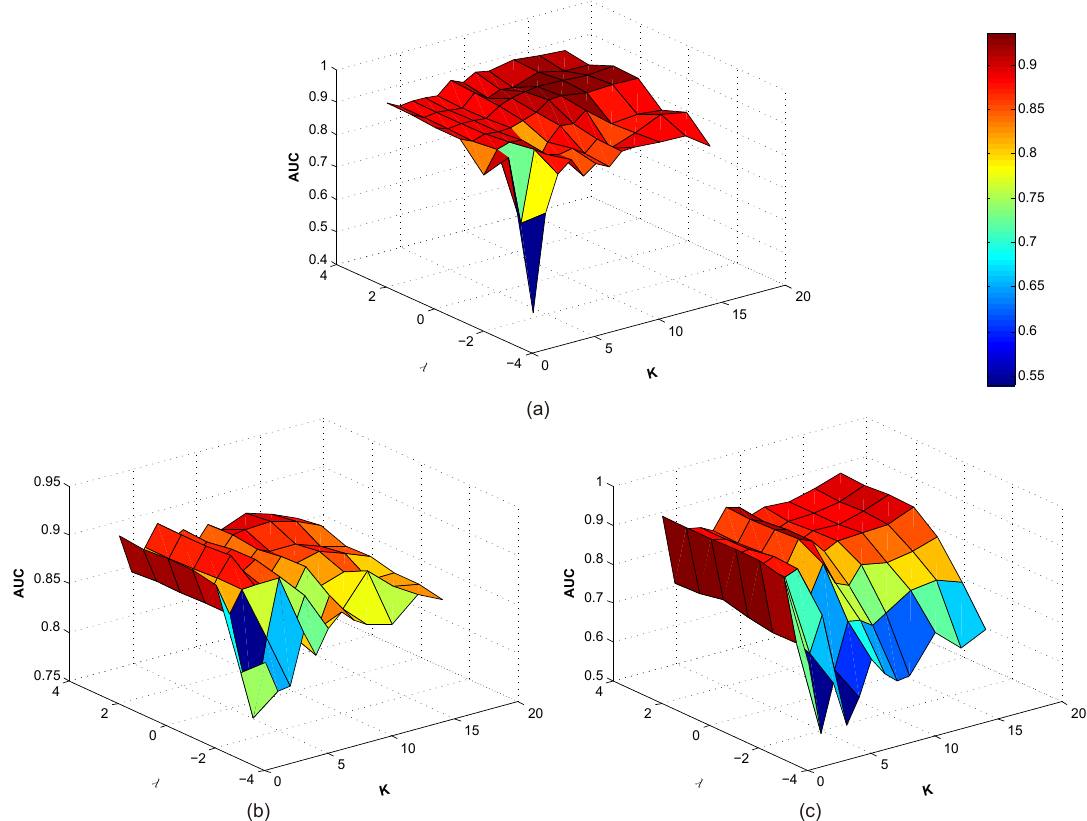
Figure 6. The experimental results of different settings of the number of clusters K and the regularized parameter λ on three hyperspectral images. ( a ) Urban data set; ( b ) AVIRIS1 data set; ( c ) AVIRIS2 data set. Values in the color bar represent the anomaly probability.